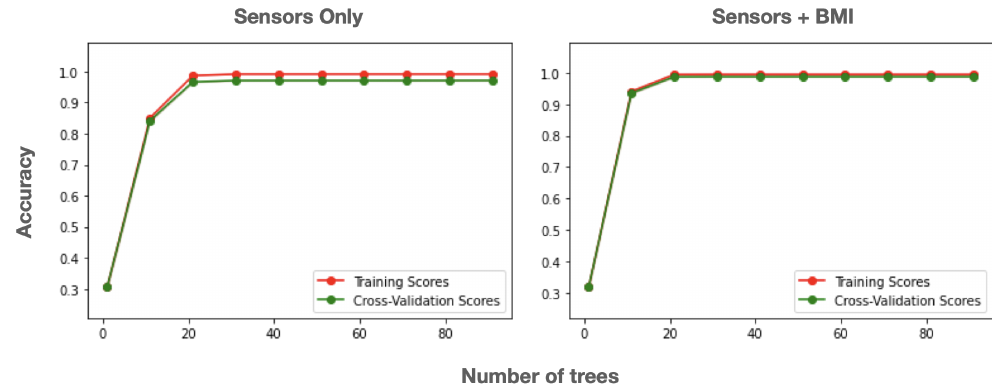
Figure 7. Validation curve (accuracy) for random forest in the sitting posture recognition task when using sensor data only ( left ) and when using sensor data and BMI ( right